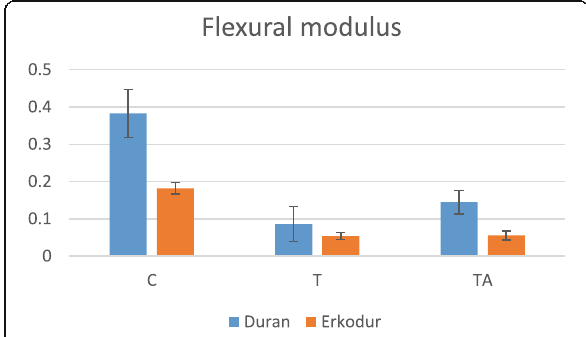
Fig. 3 Changes in flexural modulus according to the material and groups